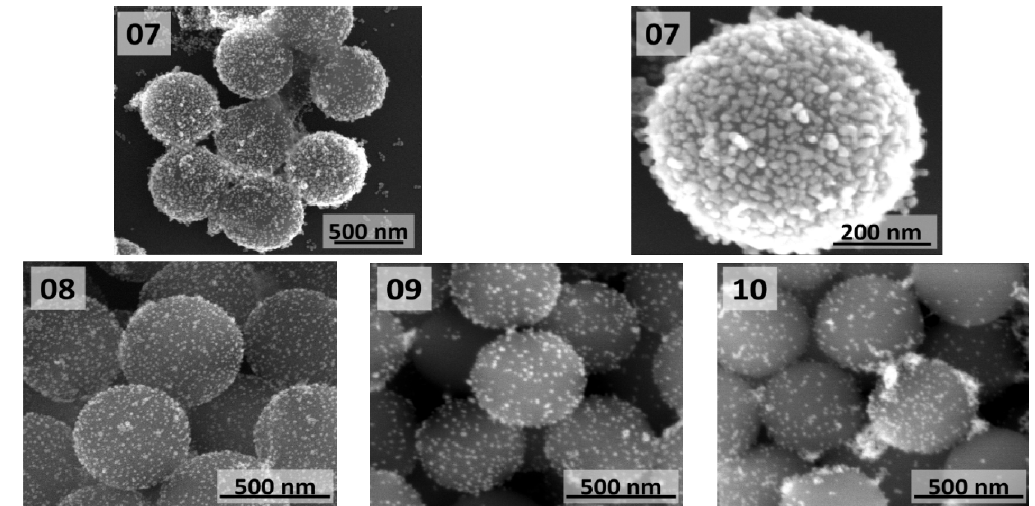
Figure 6. SEM images of SiO 2 @Au nanostructures obtained by direct reduction of gold salts in reaction mixture containing different amounts of functionalized SiO 2 particles: ( 07 ) 2.5 µg/mL; ( 08 ) 13 µg/mL; ( 09 ) 50 µg/mL; and ( 10 ) 125